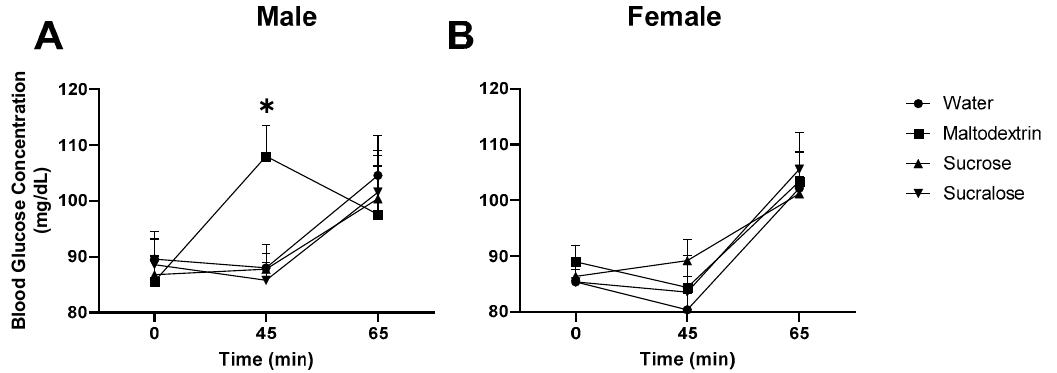
Figure 4. Blood glucose concentration (mg / dL) at baseline (0 min), after the pre load (45 min), and after the test meal (65 min) for water, maltodextrin, sucrose and sucralose preloads, in male ( A ) and female ( B ) panelists. Bars represent mean plus SEM. Stars denote statistical significance, * p < 0.05.